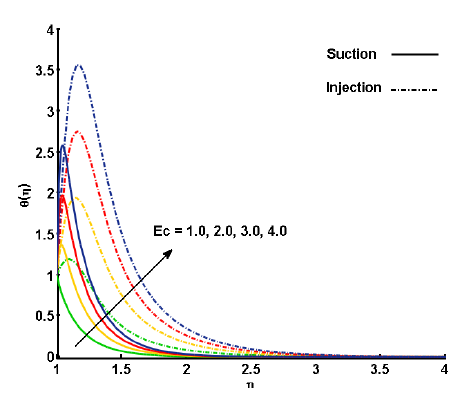
Figure 6. Effect of Eckert number ( Ec ) on temperature profile ( θ ( η )